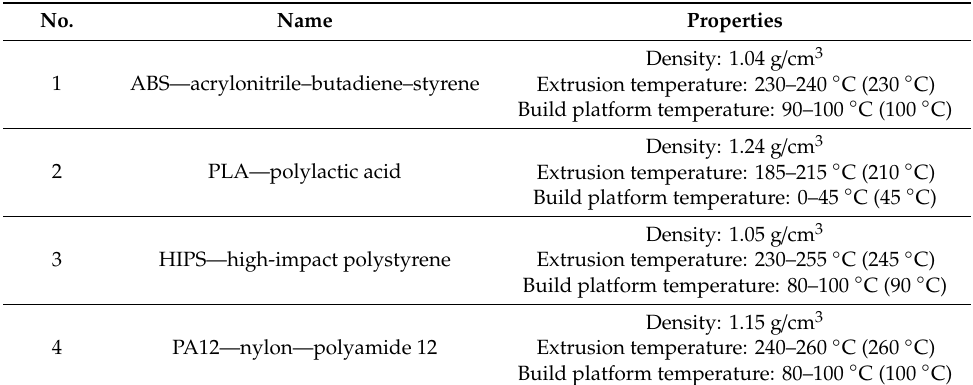
Table 2. Characteristics of materials